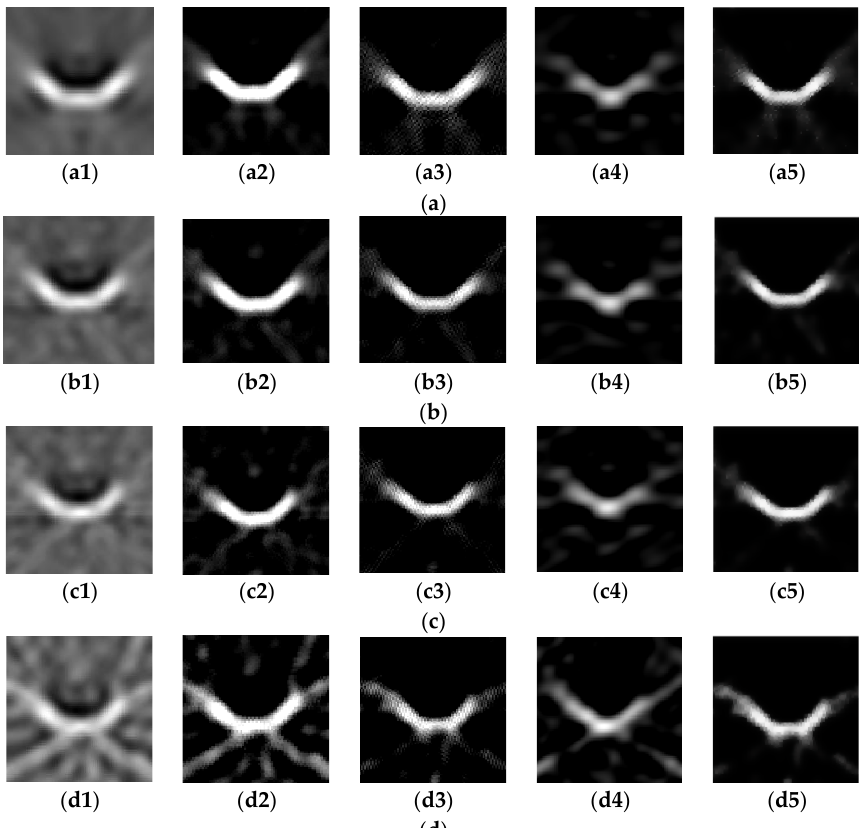
Figure 11. Far-field experimental imaging results with uniformly sampled views of projections ( Far left ) iRadon; ( Left ) FBP; ( Middle ) ART; ( Right ) sparse ART with OMP; ( Far right ) TV sparse reconstruction with ART. ( a ) Complete view data (a1:a5); ( b ) sampled data at 5° intervals (b1:b5); ( c ) sampled data at 10° intervals (c1:c5); ( d ) sampled data at 20° intervals (d1:d5). Table 4. IE, NRSNR, and Var value of different algorithms in far-field experiment.